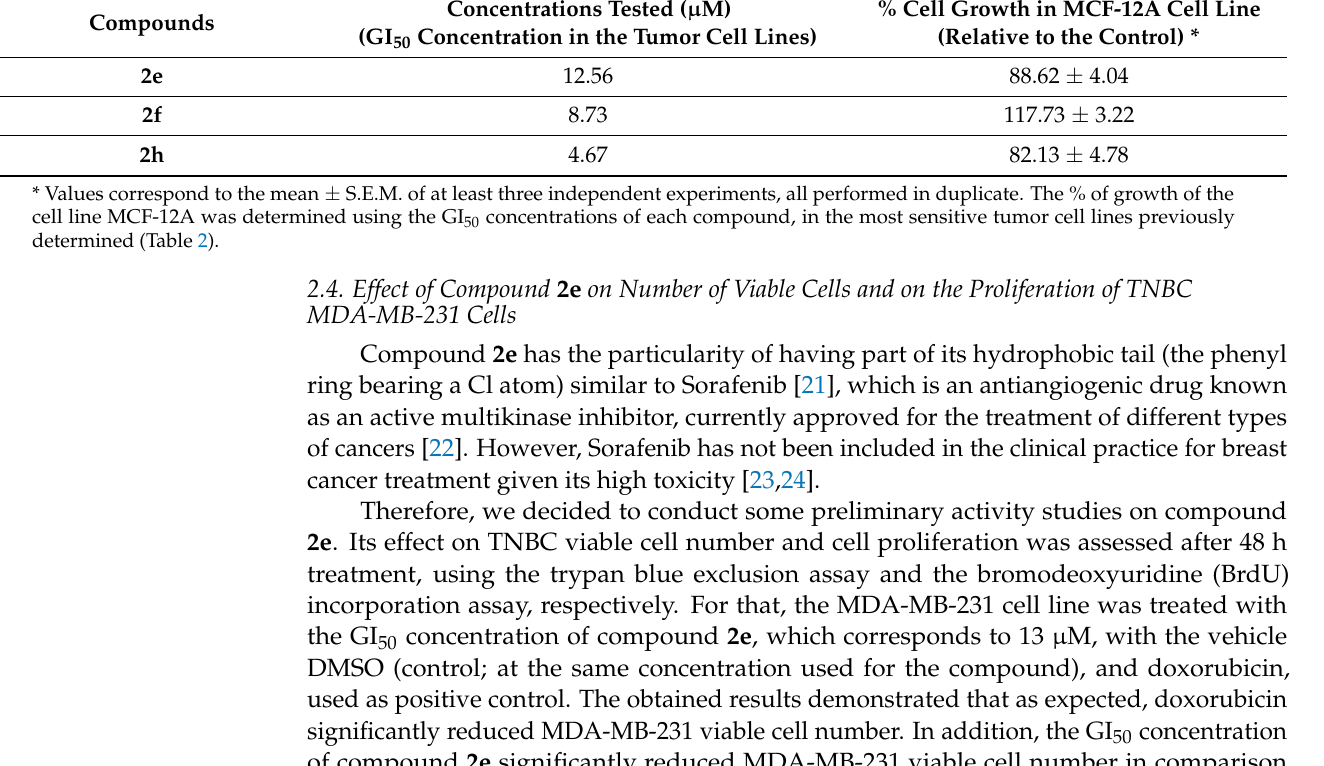
Table 3. Evaluation of the cytotoxicity of the three most promising compounds in the non-tumorigenic cell line MCF-12A, using the SRB assay. Compounds